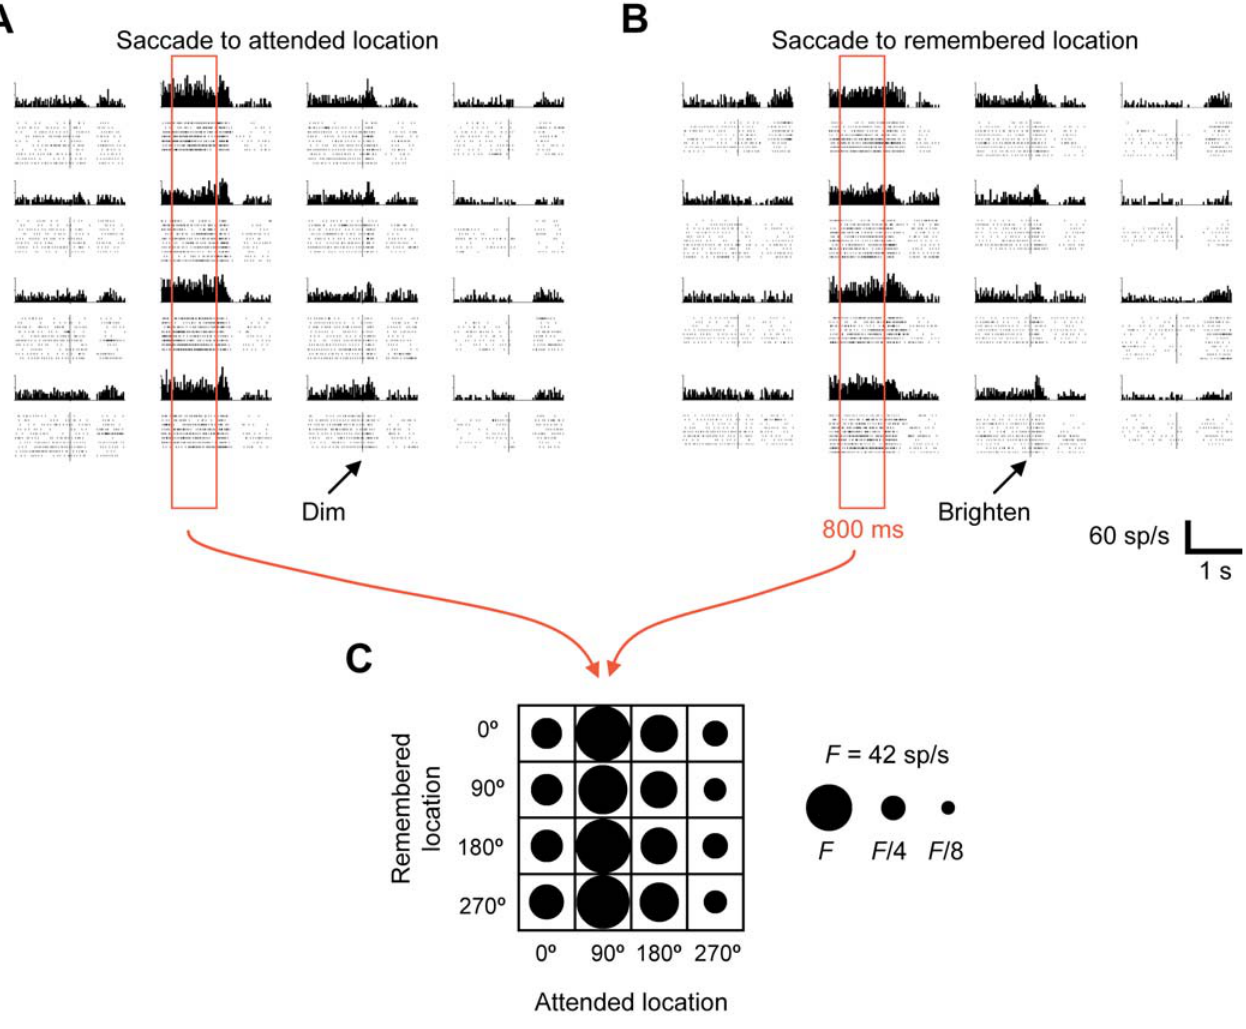
Figure 2. Example Neuron Representing the Attended Location In (A–C), the four rows correspond to different remembered locations and the four columns to different attended locations (see key in [C]). (A and B) PETHs and raster displays aligned on the trigger signal (vertical line). In the rasters, each dot represents a neuronal spike, and each line of dots shows a sequence of spikes during a single behavioral trial. (A) Trials in which the stimulus dimmed and the monkey made a saccade to the attended location (Att-trials). (B) Trials in which the stimulus brightened and the monkey made a saccade to the remembered location (Rem- trials). The activity of this neuron depended on where the monkey attended, with a preferred location of 90 8 . Note the large variation in firing rate from column to column (across the attended locations) and relative constancy of rate within columns (across remembered locations). (C) Compact representation of spatial tuning pattern shown in (A) and (B), combined. Each circle’s area is proportional to the average firing rate during the 800-ms period immediately preceding the trigger signal (red rectangle in [A] and [B]). Note that the major diagonal of this firing-rate matrix, running from the upper left to the lower right corner, corresponds to the control trials, which lacked a memory requirement. F, maximal firing rate; sp/s, spikes per